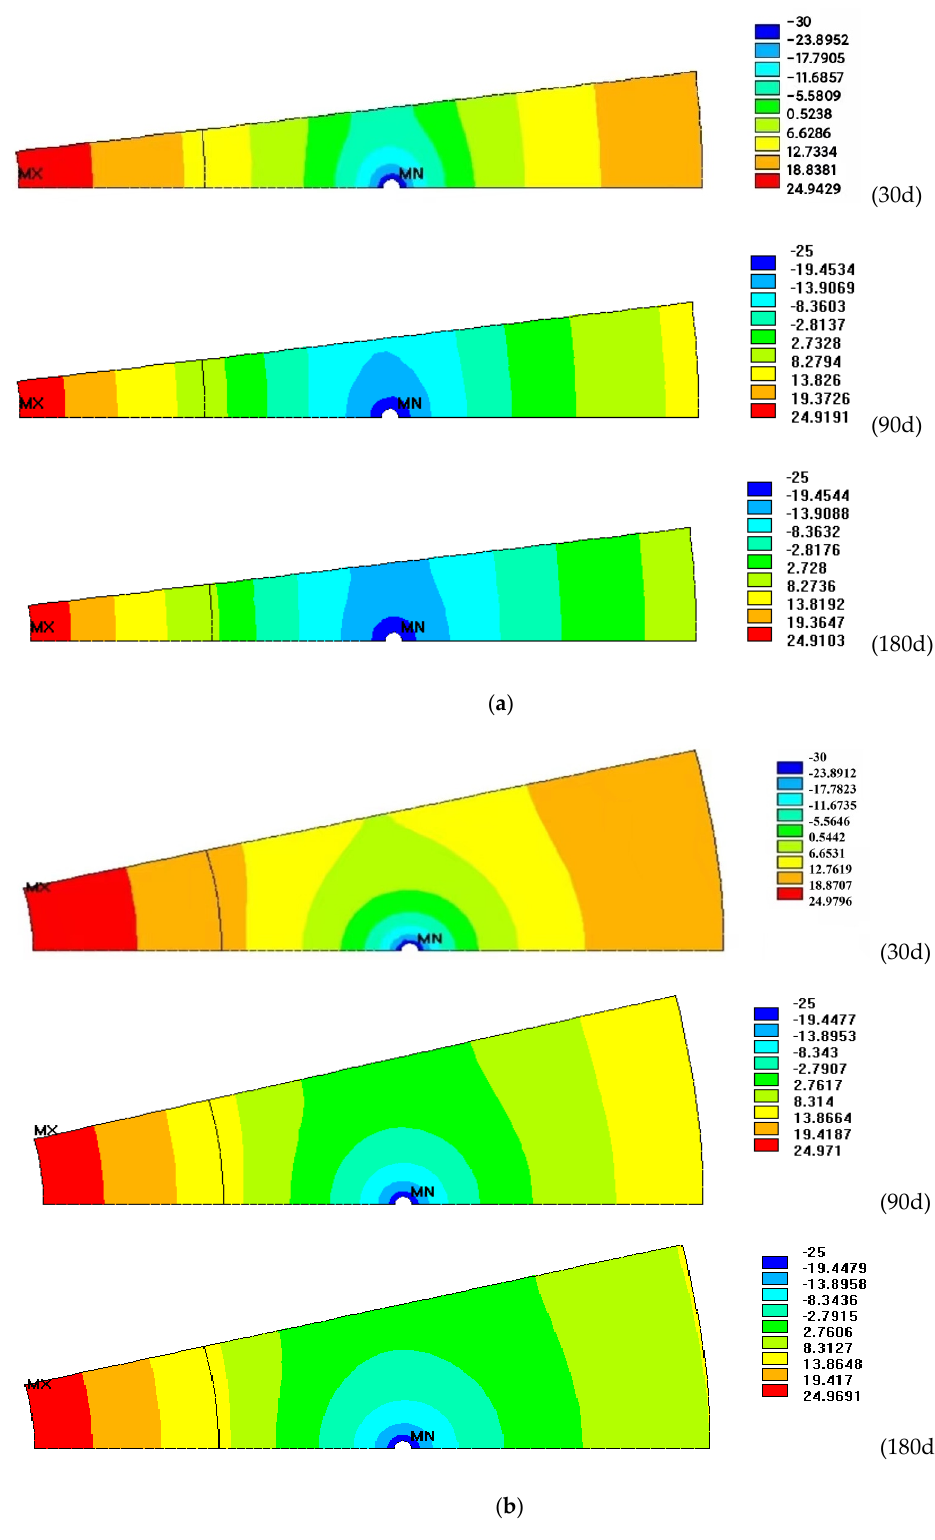
Figure 13. Temperature contours within 30 d, 90 d, and 180 d: ( a ) freezing tube pitch of 1.3 m, ( b ) freezing tube pitch of 2.5 m.